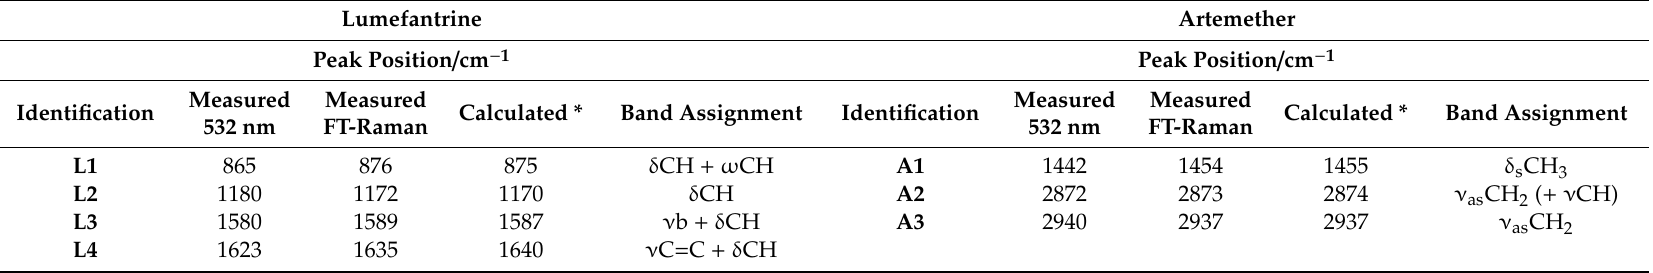
Table 1. Band assignment of the prominent Raman peaks of lumefantrine and